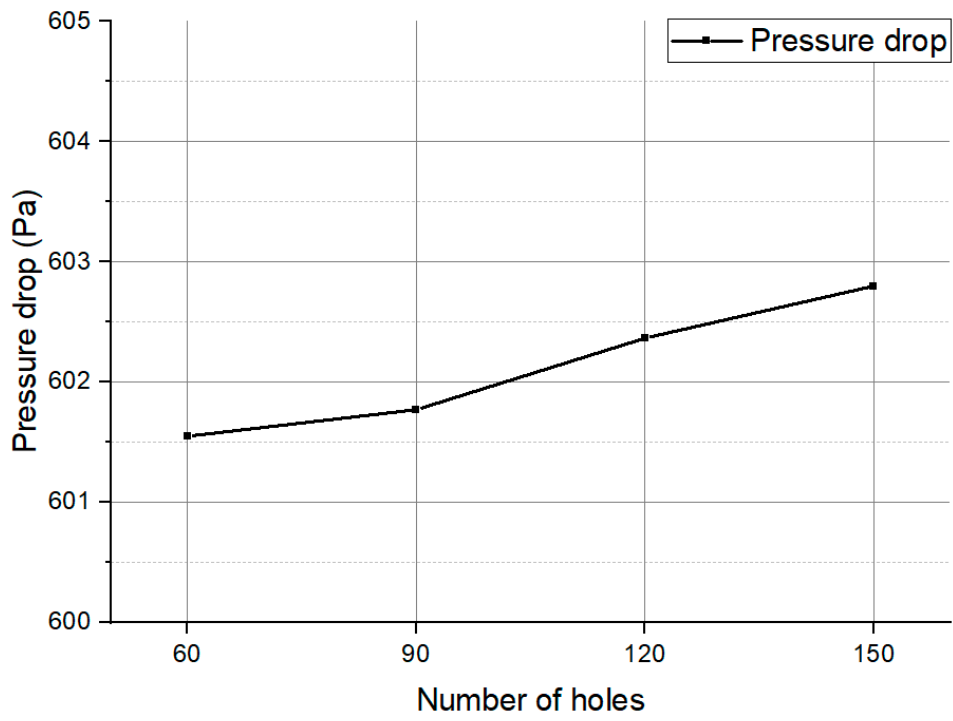
Figure 27. Pressure drop graph according to the number of holes in the inner resonate type.